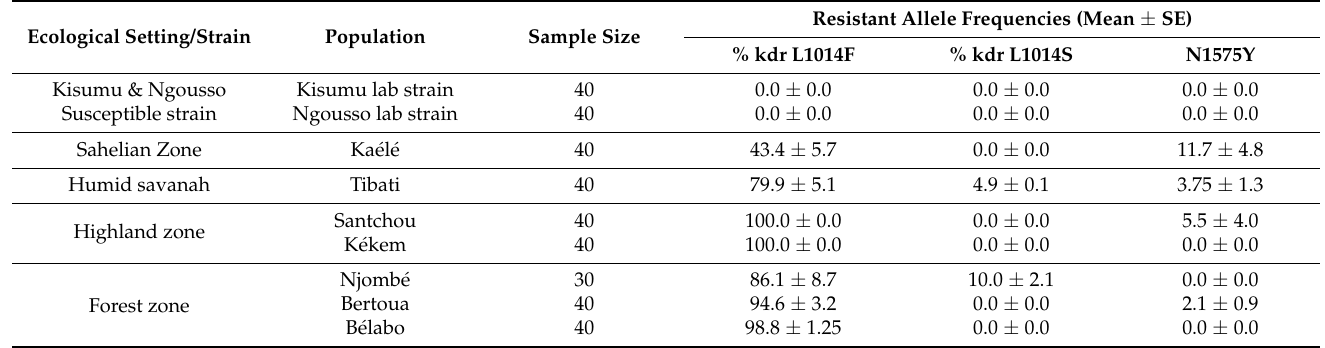
Table 1. Frequencies of kdr L1014F, L1014S and N1575Y resistance alleles in An. gambiae s.l. populations.